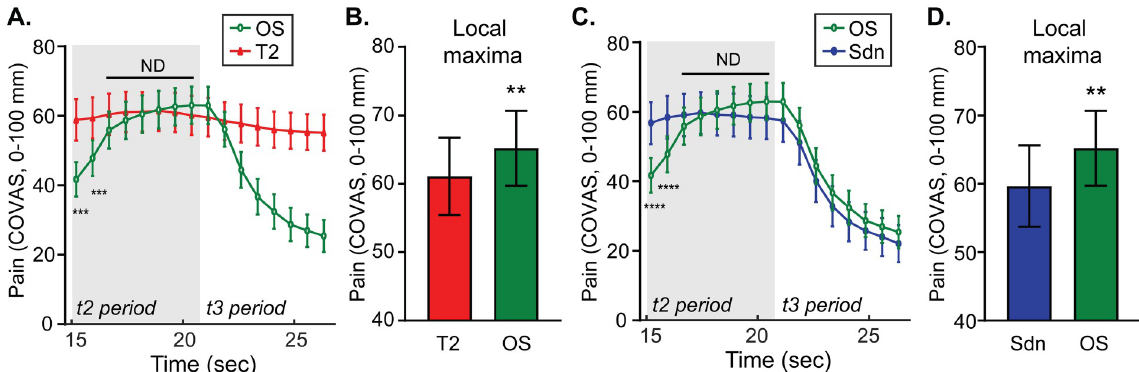
Fig 6. An increase in temperature within the noxious range without an immediately preceding decrease produces a comparatively small increase in pain intensity. A. Group mean continuous pain intensity rating curves during the t2 periods and beginning of the t3 periods of the OS (green circles) protocol and T2 control (red triangles) protocol are plotted. B. Group mean pain intensity local maxima during the OS stimulus protocol and the pain intensity at the equivalent timepoint during the control T2 stimulus are plotted. C. Group mean continuous pain intensity rating curves from the OS (green circles) and Sdn (blue circles) stimuli are plotted. D. Group mean pain intensity local maxima during the OS stimulus and the pain intensity at the equivalent timepoint during the control Sdn stimulus are plotted. For all graphs (A.–D.), group means are plotted with error bars representing 95% CI. P-values: �� p < 0.01, ��� p < 0.001, ���� p < 0.0001. ND = no difference (p >